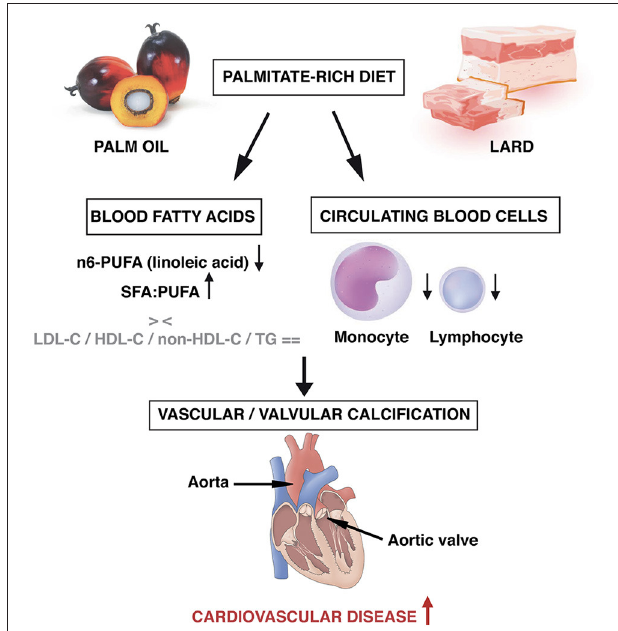
FIGURE 4 | Intake of regular amounts of palmitate, a major dietary saturated fatty acid contained in palm oil and in lard, may promote calcification in aorta and in aortic valve, responsible for an increased burden of cardiovascular disease. In blood, decreased levels of polyunsaturated fatty acids as well as signs of low-grade inflammation may occur, without any changes in traditional cholesterol